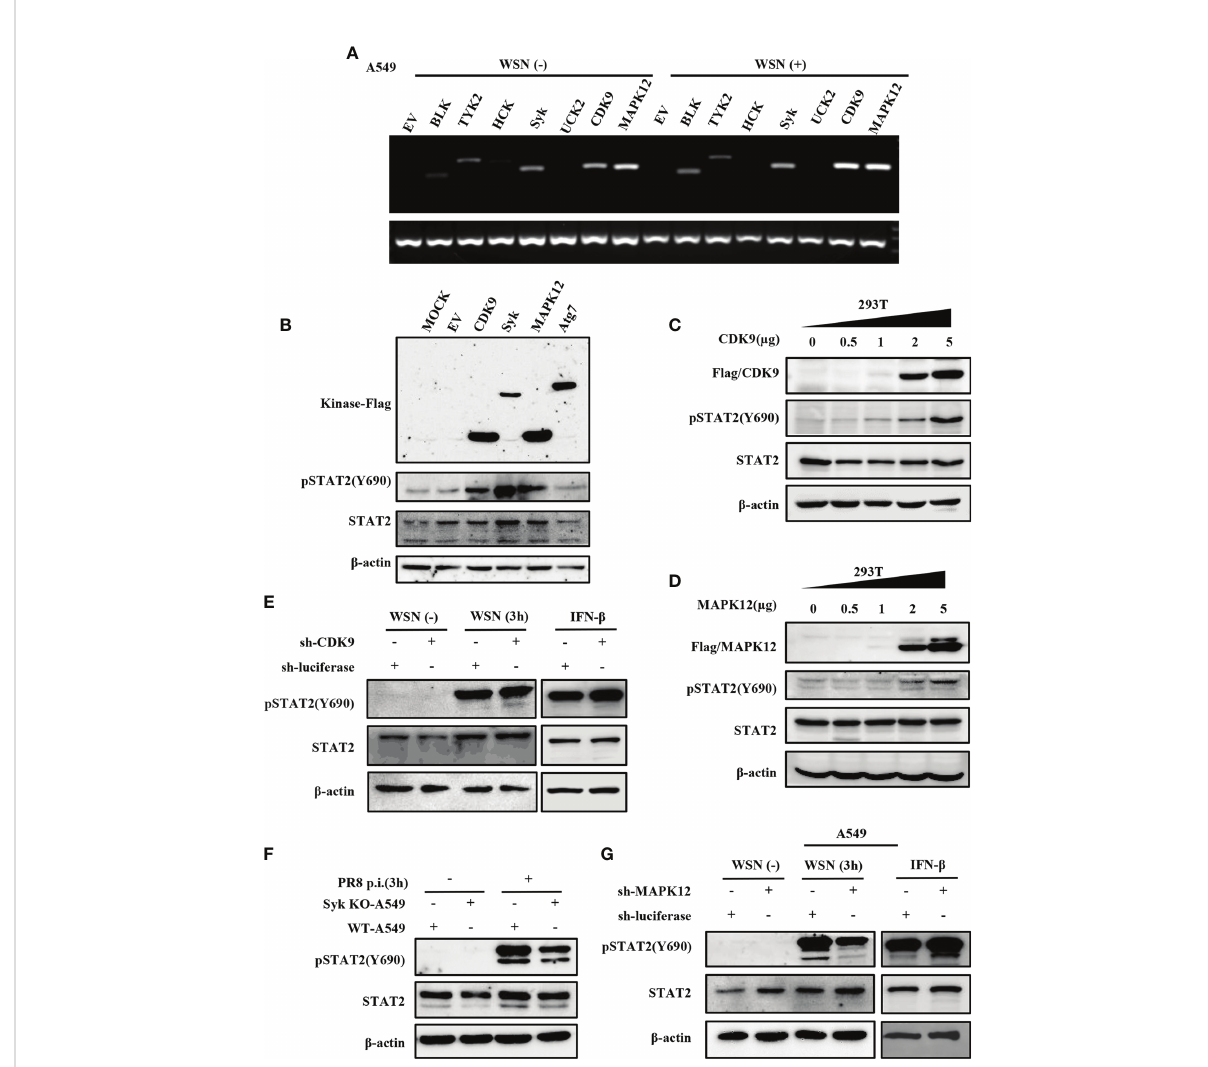
FIGURE 6 Several kinases are involved in early activation of STAT2 induced by IAV infection. (A) A549 cells were infected with or without WSN for 3 h, and the expression of various kinases was detected by RT-PCR. (B) 293T cell lines were transfected with different kinase plasmids for 24 h (MOCK as blank control, EV and Atg7 as negative control). Western blotting was performed to evaluate the pSTAT2 levels. (C, D) 293T cells were transfected with increasing amounts of MAPK12 (D) and CDK9 (C) -expressing plasmids as indicated or empty vector as control for 24 (h) Western blotting was performed with the indicated antibodies. Plotted are the representative data of three repeated experiments. (E, G) Sh- RNA-based A549 cells lines stably expressing CDK9 (E) , MAPK12 (G) , or control (luciferase) were infected with WSN with (MOI =1) for 3 h or stimulated by IFN- b (0.1 m g/mL) for 45 min, and the corresponding protein levels were detected by Western blotting. (F) Syk knockout A549 cells (Syk KO-A549) or control cells (WT-A549) were infected with PR8 (MOI =1) for 3 h and then protein samples were collected. The pSTAT2 was detected by Western blotting. The above data are representative results of three independent